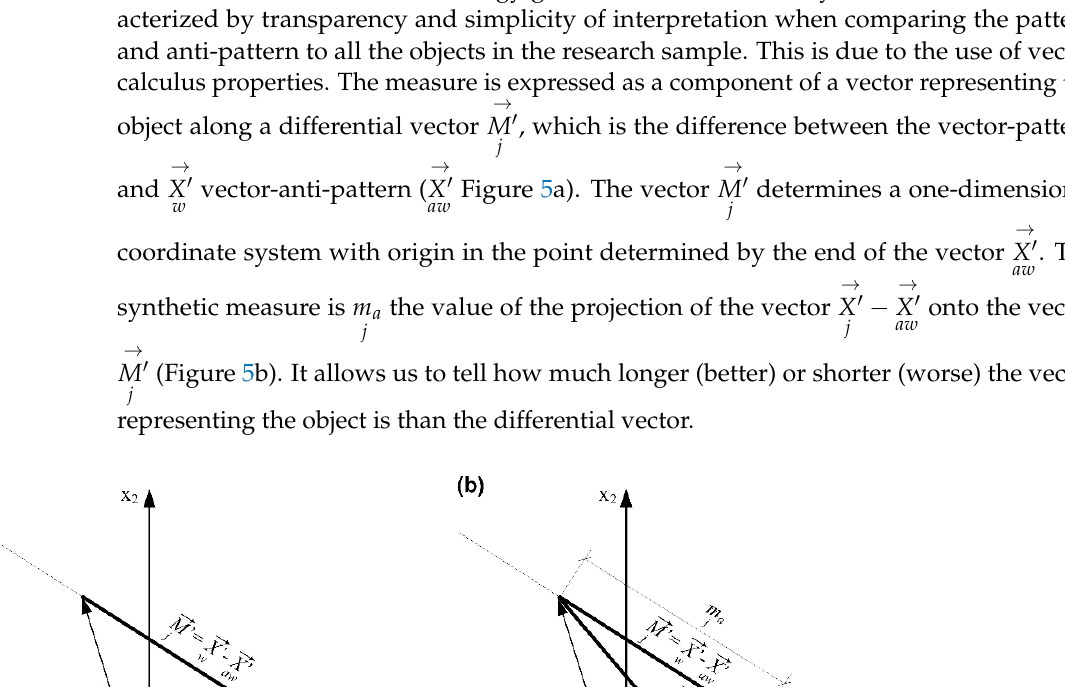
 → ′ M ; ( b ) synthetic M (cid:48) ; ( b ) synthetic measure m a j j